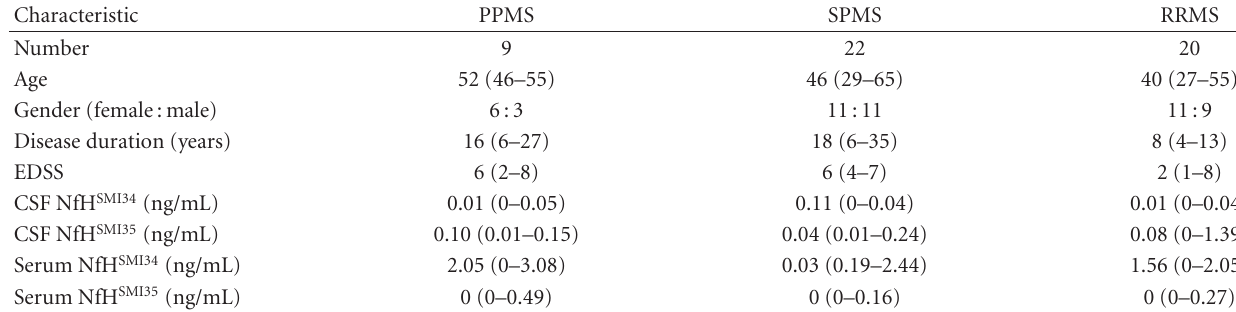
Table 1: Patient characteristics at baseline. The median (range) is shown.